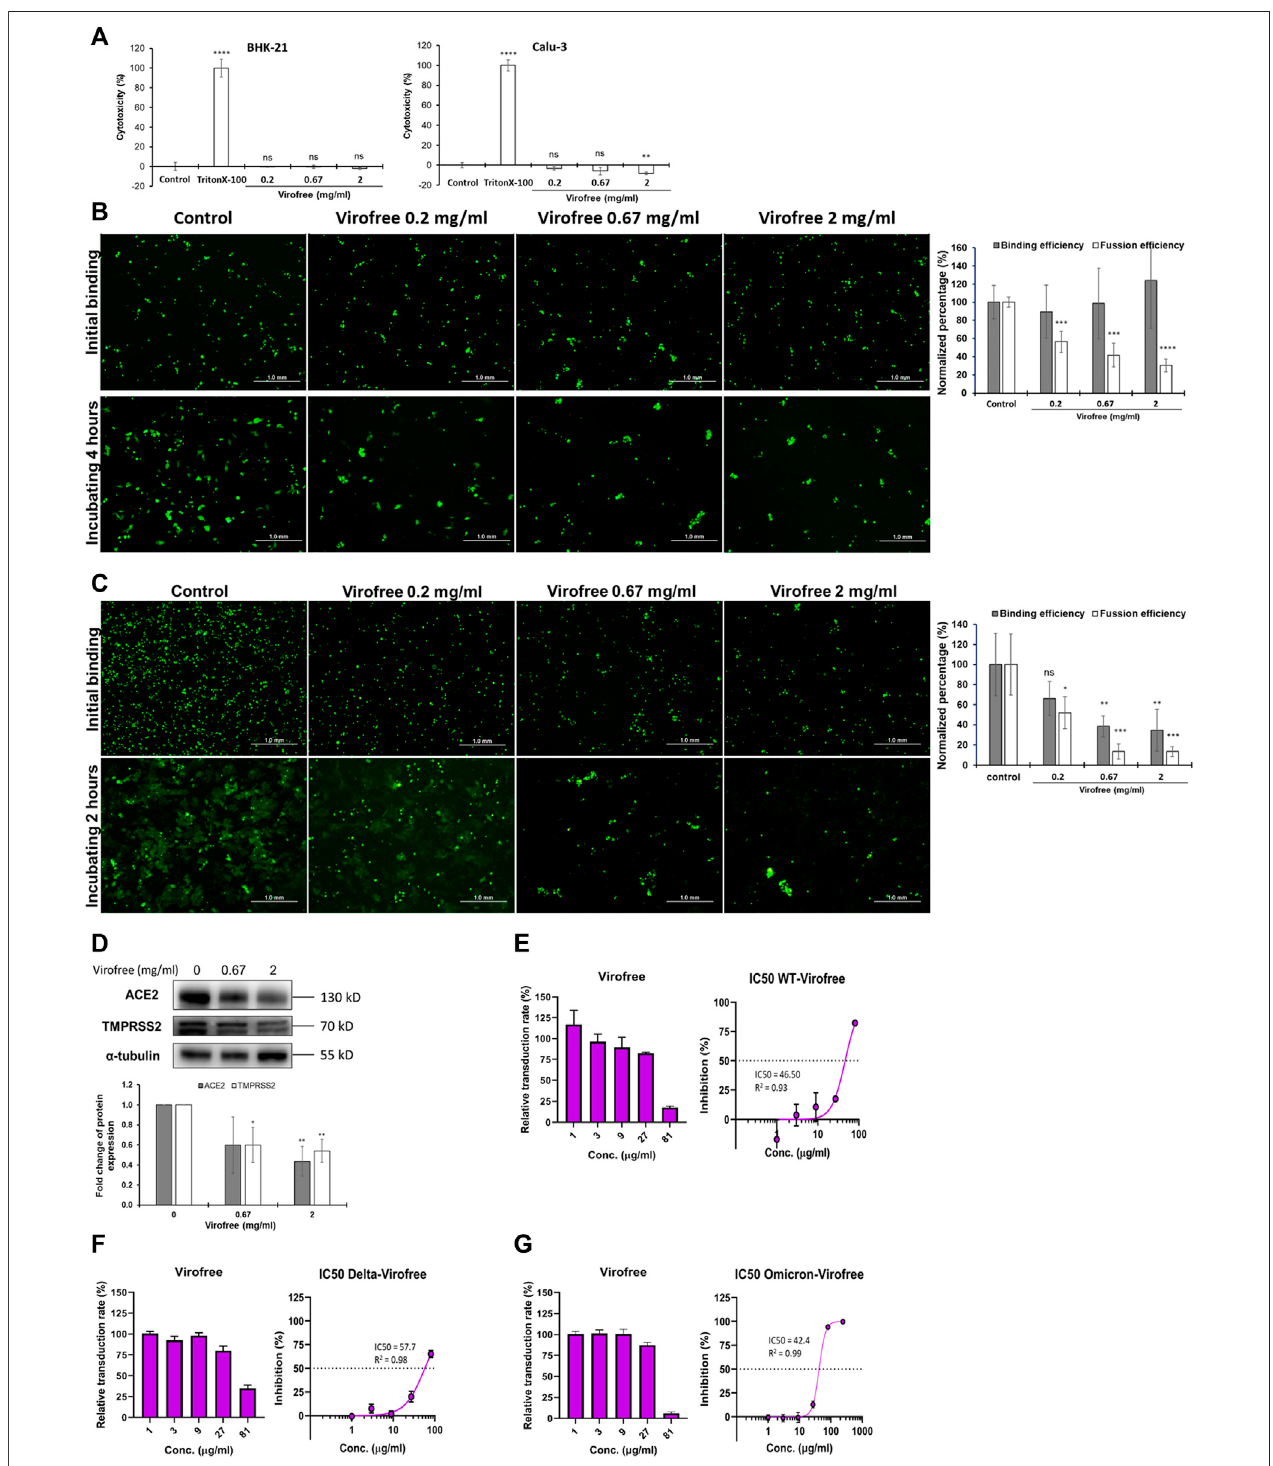
FIGURE 4 | Virofree can interfere with SARS-CoV-2-spike-mediated binding and syncytium formation in cell-based assays. (A) cytotoxicity of Virofree was validatedbytheLDHcytotoxicityassay.BHK-21andCalu-3cellsweretreatedwithindicatedamountsofVirofree,andthecellularcytotoxicityofVirofreewasdetermined by LDH assay. The control group represented no Virofree-treated group, using it as a negative control. The treatment with Triton-100 was serving as a positive control. Thedatawerepresentedasthemean±SD;errorbarsindicatedSD.nsindicatednon-signi fi cantcomparedtothecontrolgroup.** p < 0.01and**** p < 0.0001. (B, C) EGFP and wild-type (B) or Delta. (C) spike co-expressed BHK21 cells were added into Calu-3 cells and incubated at 4 ° C for 1 h for spike-ACE2 binding. After 4 h